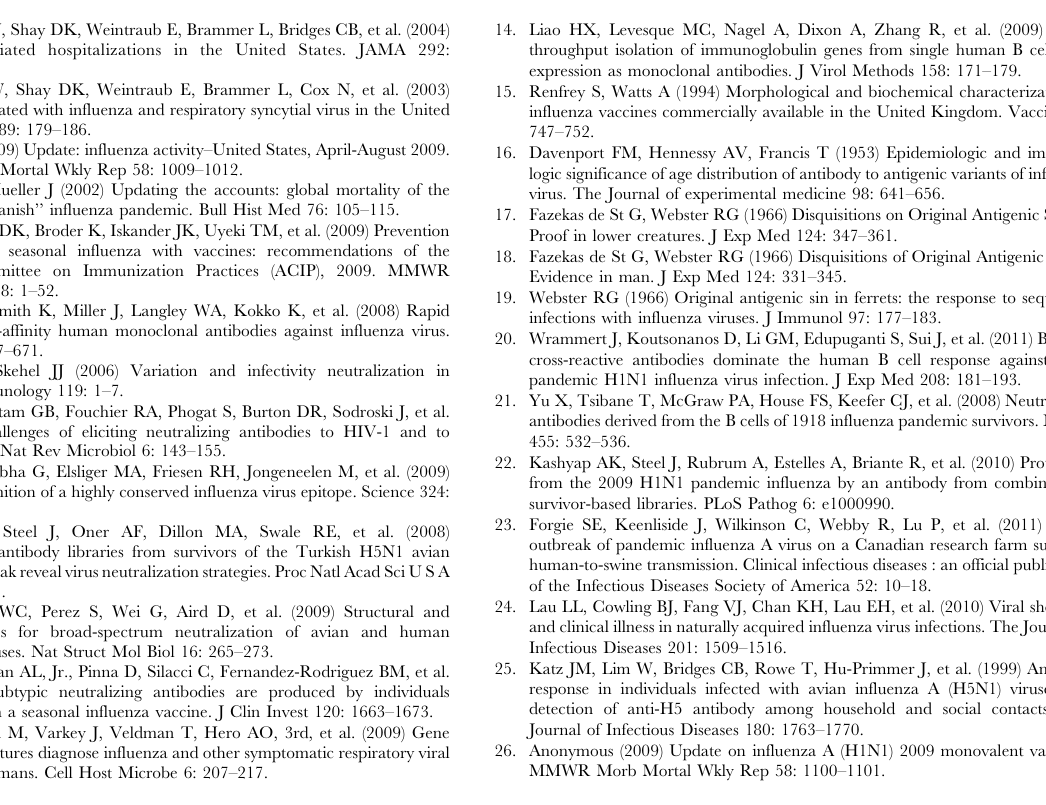
Table S9 Lambda chain family usage of isolated influenza-specific rmAbs. Table S10 Lambda chain family usage of isolated rmAbs not specific for influenza antigens. Table S11 Characteristics of cross-reactive